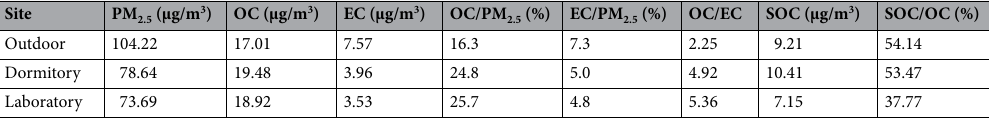
Table 2. Mass concentration of indoor and outdoor PM 2.5 , OC, EC, and SOC.